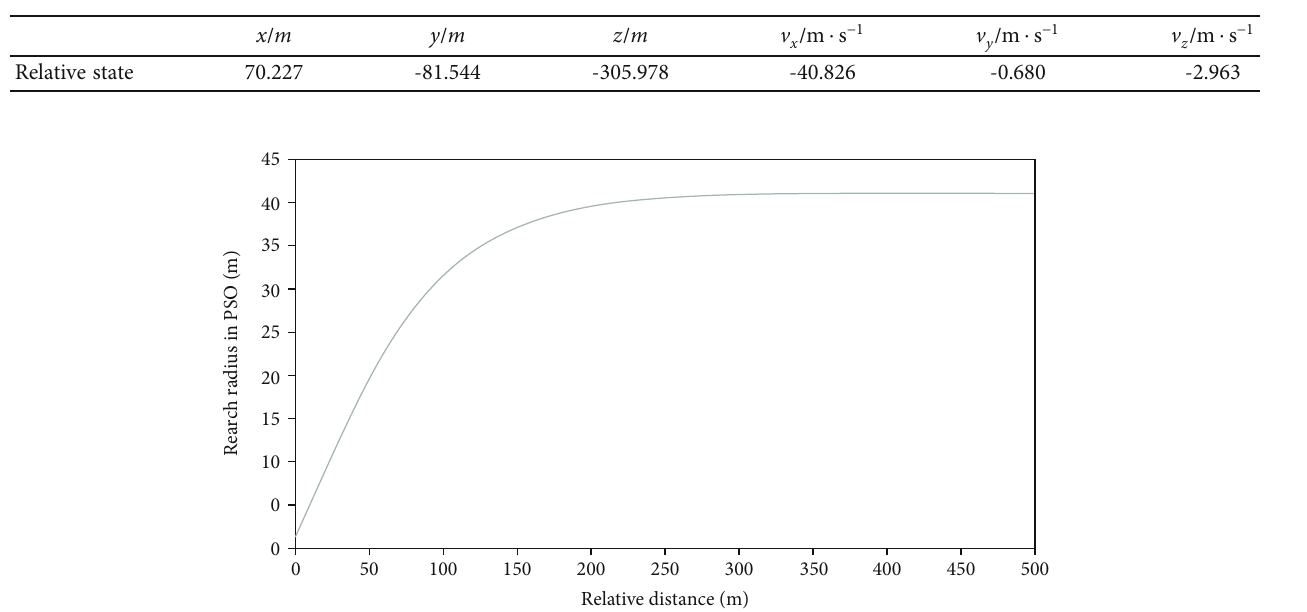
Table 4: The state of the spacecraft relative to the goal in the CW coordinate system at the initial moment of the stage of returning from the close proximity.